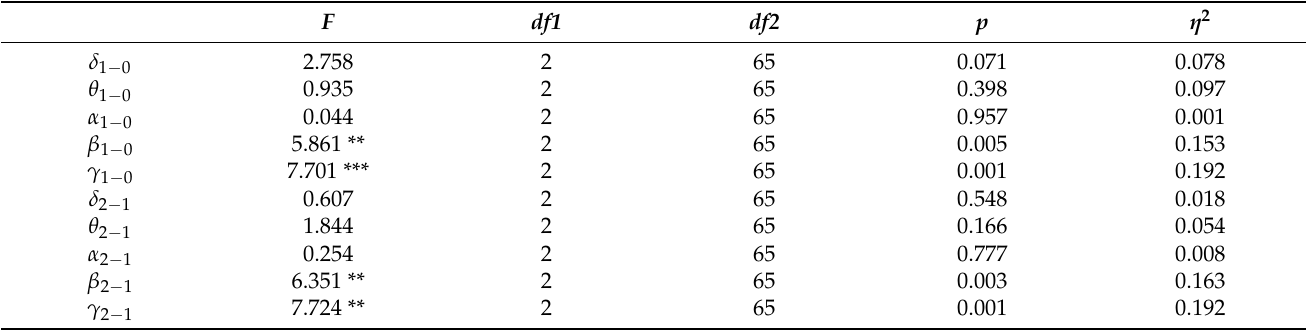
Table A11. Results of one-way ANOVA of PSD changes in each frequency band.